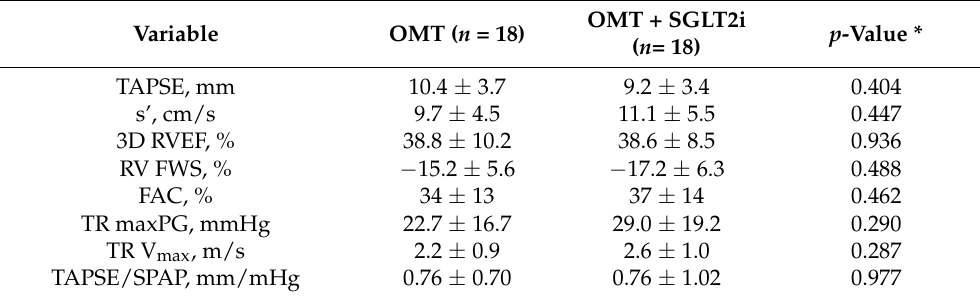
Table 2. Right-sided functional echocardiographic parameters at baseline, stratified by the type of treatment received (OMT vs. OMT + SGLT2 inhibitor).